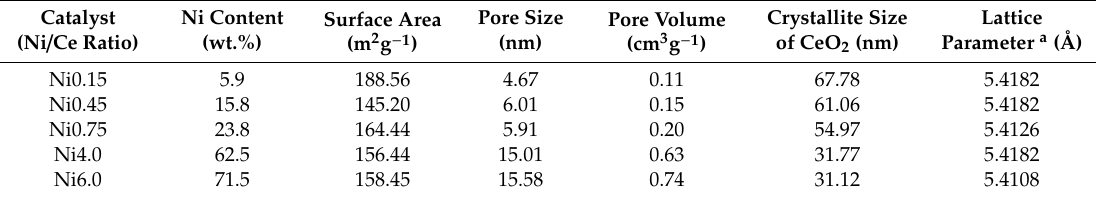
Table 1. Textural and crystal structural properties of Ni-Ce-ZrO δ